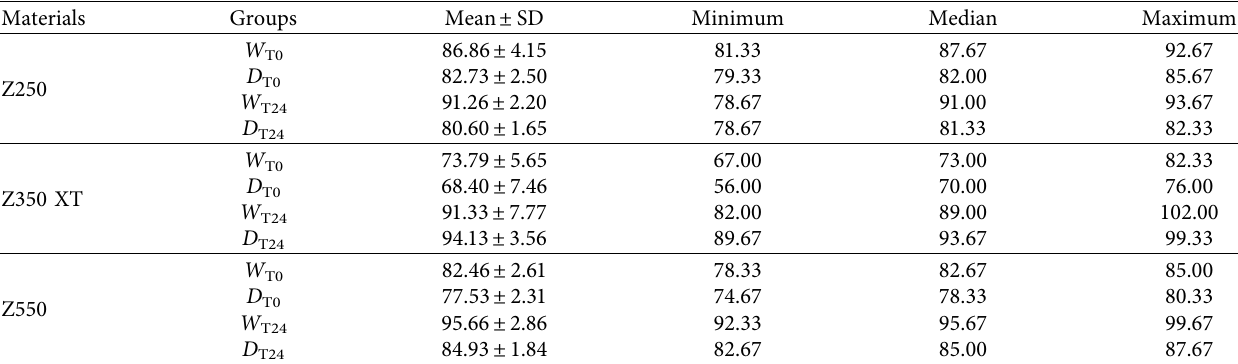
Table 4: Mean ± SD, minimum, median, and maximum values of surface hardness of the samples.